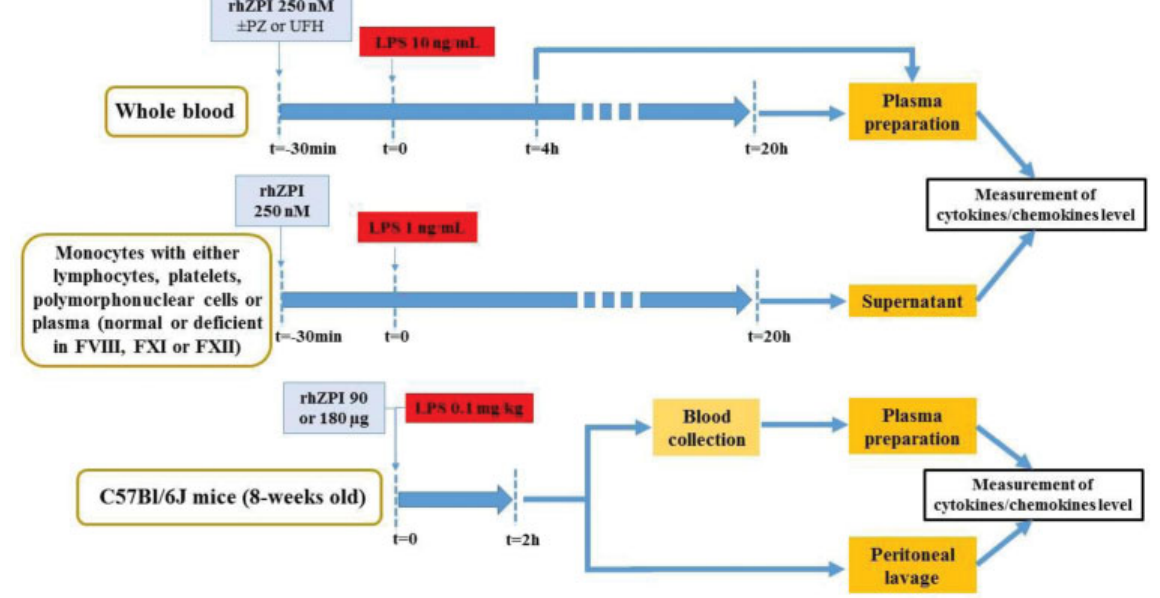
Fig. 1 Design of the study. Effects of recombinant human ZPI (rhZPI) was analysed either in whole blood or on isolated fractions of blood (monocytes alone, monocytes and lymphocytes, in the presence or not of platelets or polymorphonuclear cells, and with normal plasma or coagulation factor de fi cient plasmas). Lipopolysaccharide (LPS) from E. coli 0111:B4 was used to stimulate monocytes or to induce in vivo in fl ammation